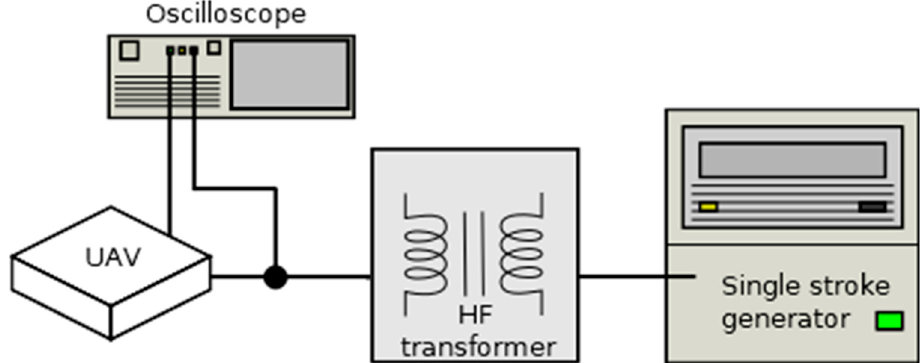
Figure 2. Block diagram of the drone (the same peripherals are the same block color) with numbered measurement points.